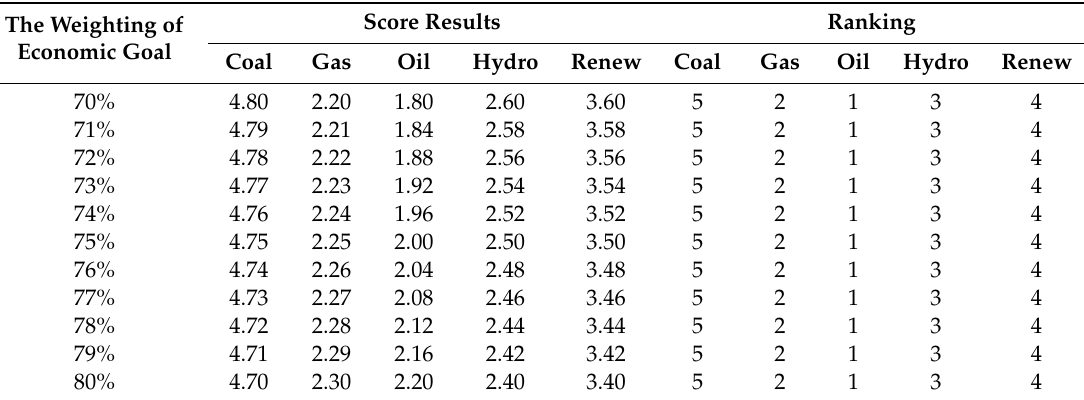
Table A2. Sensitivity analysis for the economic goal. The Weighting of Economic